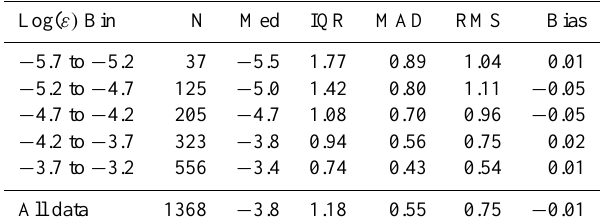
Table 4. Statistics comparing radar retrievals of dissipation rate with in situ observations from the tethersonde at ASCOS. All details are similar to Table 2 with statistics computed for the radar retrievals within bin ranges defined by the tethersonde values. A positive bias indicates that the radar retrieval is larger than the tethersonde mea- surement.